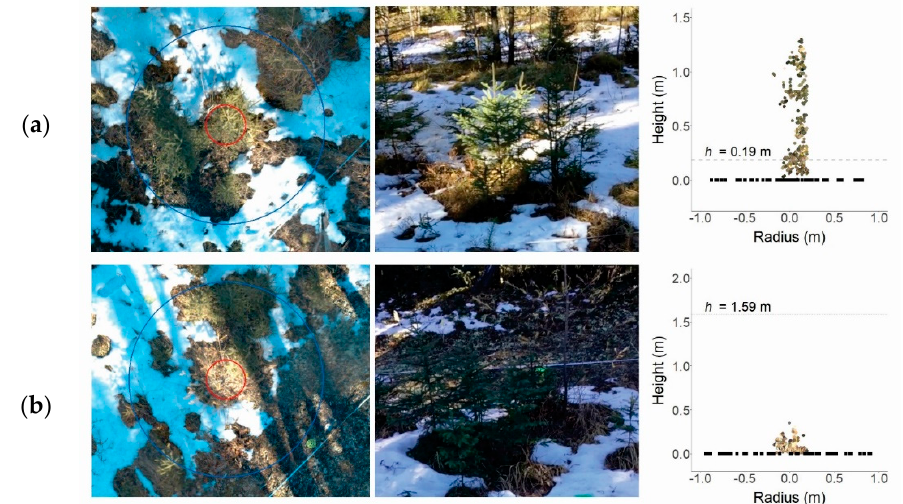
Figure 8. Example of ( a ) height overestimation of a spruce seedling (probably due to a data entry blunder) and ( b ) height underestimation of a larch seedling (leaf-off). The left panels are a nadir view of seedlings from the orthomosaic, the middle is a profile from a field photo, and the right is the 3D reconstruction.